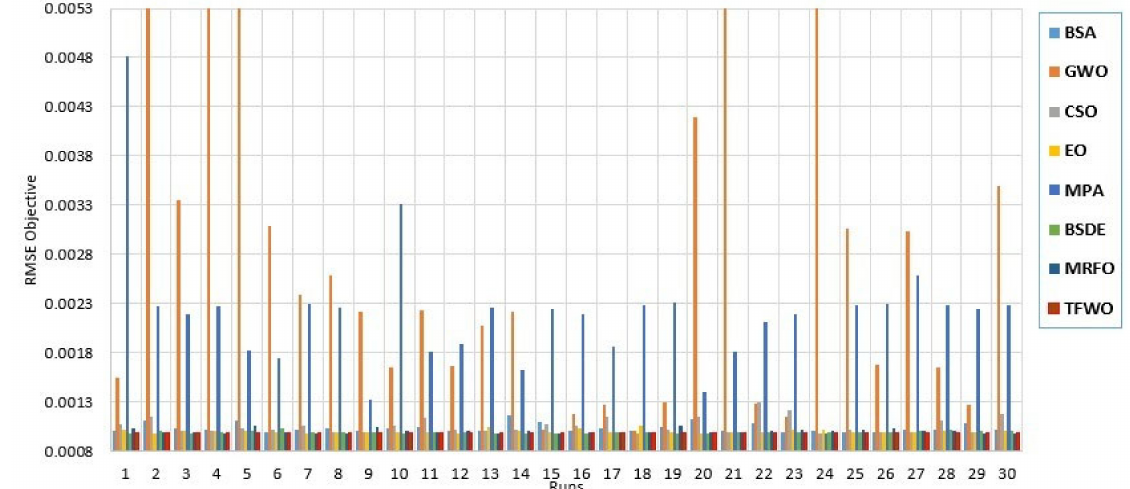
Figure 8. The RMS values of the 30 runs for R.T.C. France SDM.